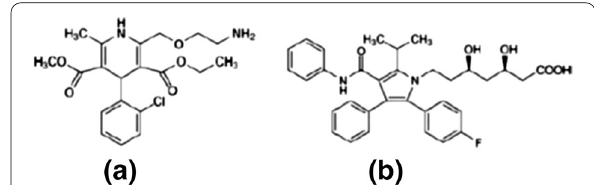
Fig. 1 Chemical structure of a amlodipine and b atorvastatin